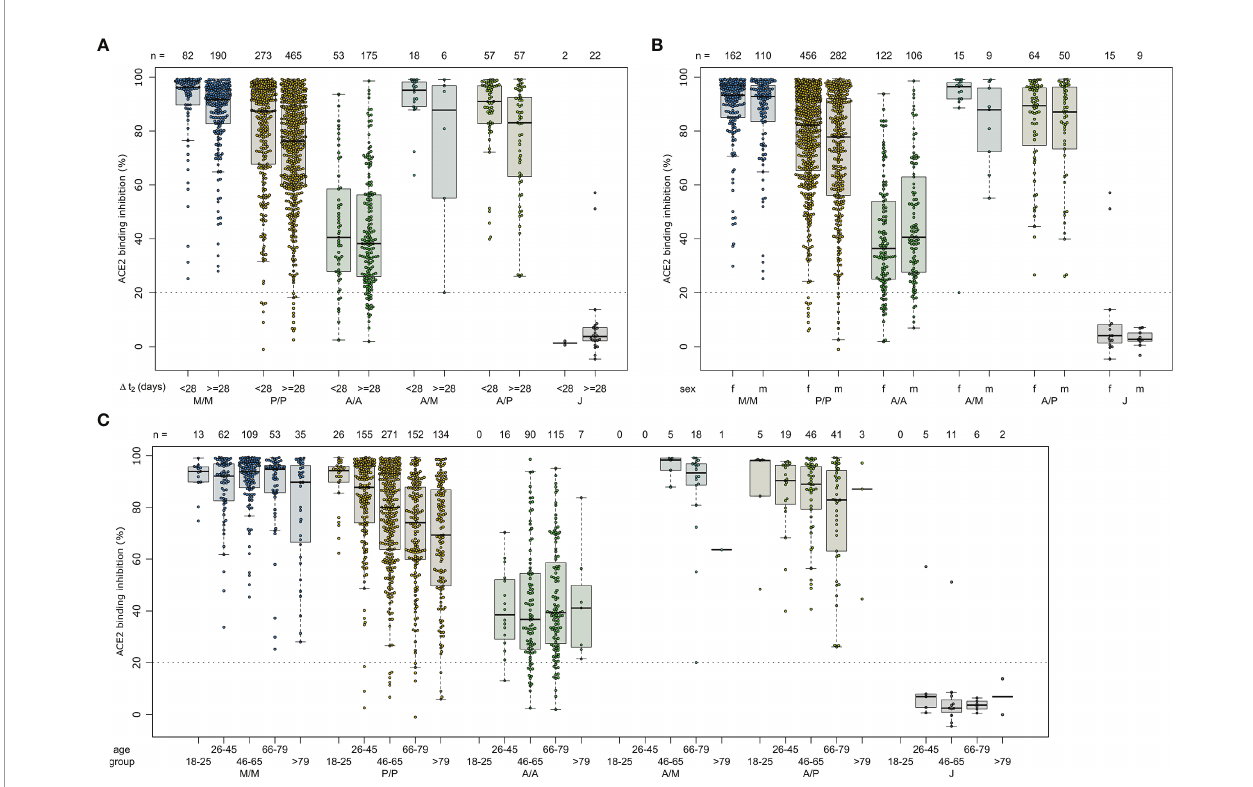
FIGURE 4 | Effect of time post-vaccination, gender and age on ACE2 binding inhibition for different SARS-CoV-2 vaccination schemes. ACE2 binding inhibition against the SARS-CoV-2 wild-type (B.1 isolate) RBD was assessed by an ACE2-RBD competition assay. Samples were split according to vaccination scheme (homologous mRNA [mRNA-1273 (M/M, blue), BNT162b2 (P/P, orange)], heterologous prime-boost (AZD1222-mRNA-1273 (A/M, light blue), AZD1222-BNT162b2 (A/P, light green) or vector-based [AZD1222-AZD1222 (A/A, green), Ad26.CoV2.S (J, grey)]. To display impact of potential confounders, samples were further split in time post-vaccination up to 27 and above 27 days (A) , gender (B) and indicated age groups (C) . Boxes represent medians, 25th and 75th percentiles and whiskers show the largest and smallest non-outlier values based on 1.5 IQR calculation. The threshold for non-responsive samples (ACE2 binding inhibition less than 20%) is shown as dotted line. All samples below this threshold can be considered non-responsive. Time between sampling and full vaccination is displayed as mean and SD for each group. Number of samples per vaccination scheme are stated below the fi gure. Statistical signi fi cance was calculated by a regression model ( Supplementary Table 4